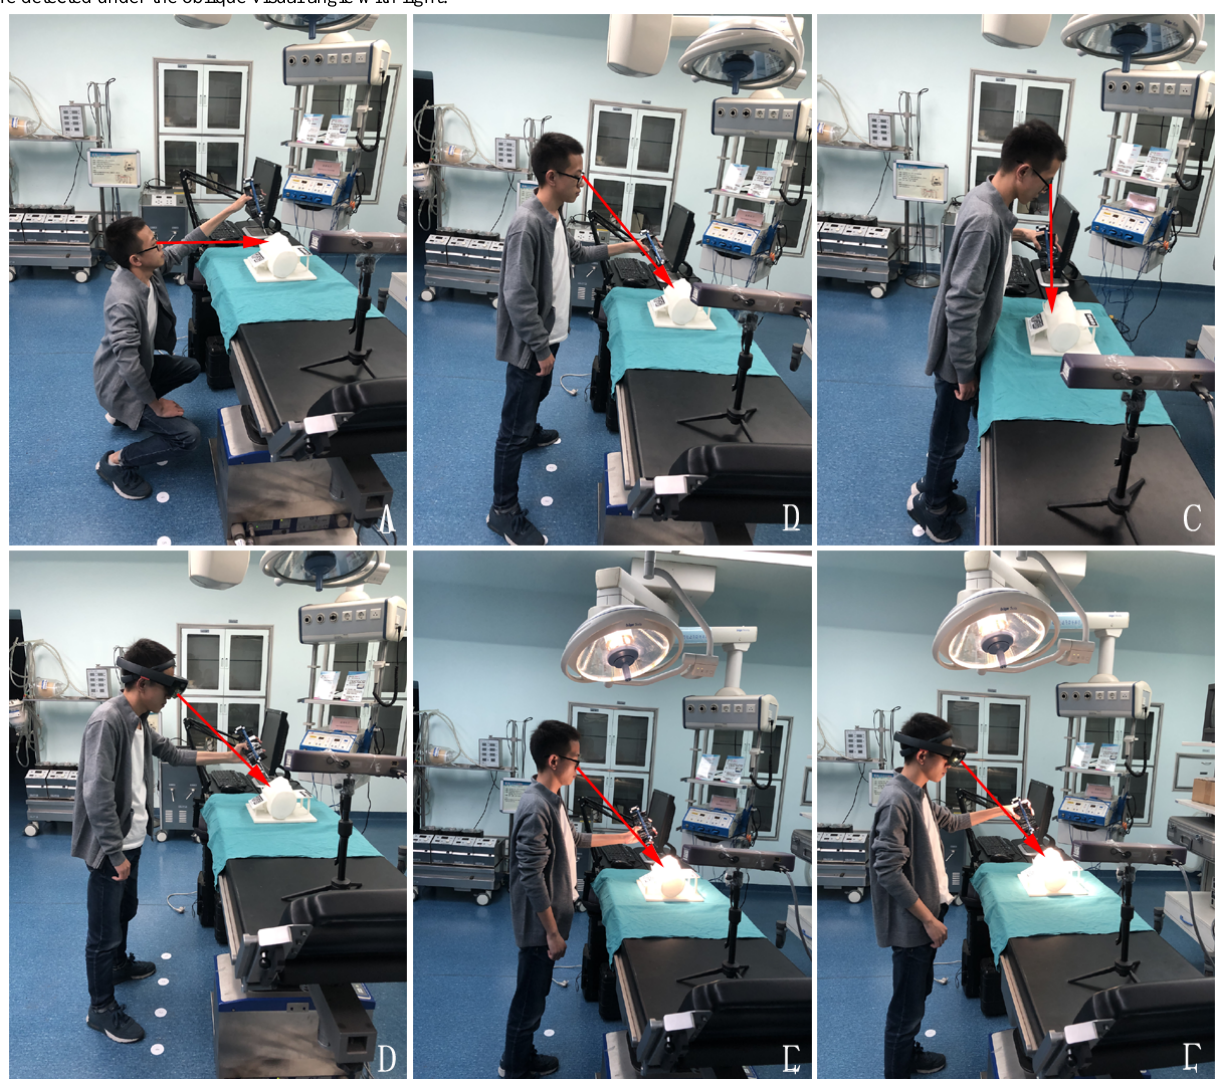
Figure 3. The coordinates of points were recorded by a tracking device (Micron Tracker) under different conditions. (A) The coordinates of points on the three-dimensional (3D) printed model were detected under the horizontal visual angle without light. (B) The coordinates of points on the 3D printed model were detected under the oblique visual angle without light. (C) The coordinates of points on the 3D printed model were detected under the vertical visual angle without light. (D) The coordinates of points on the virtual model were detected under the oblique visual angle without light. (E) The coordinates of points on the 3D printed model were detected under the oblique visual angle with light. (F) The coordinates of points on the virtual model were detected under the oblique visual angle with